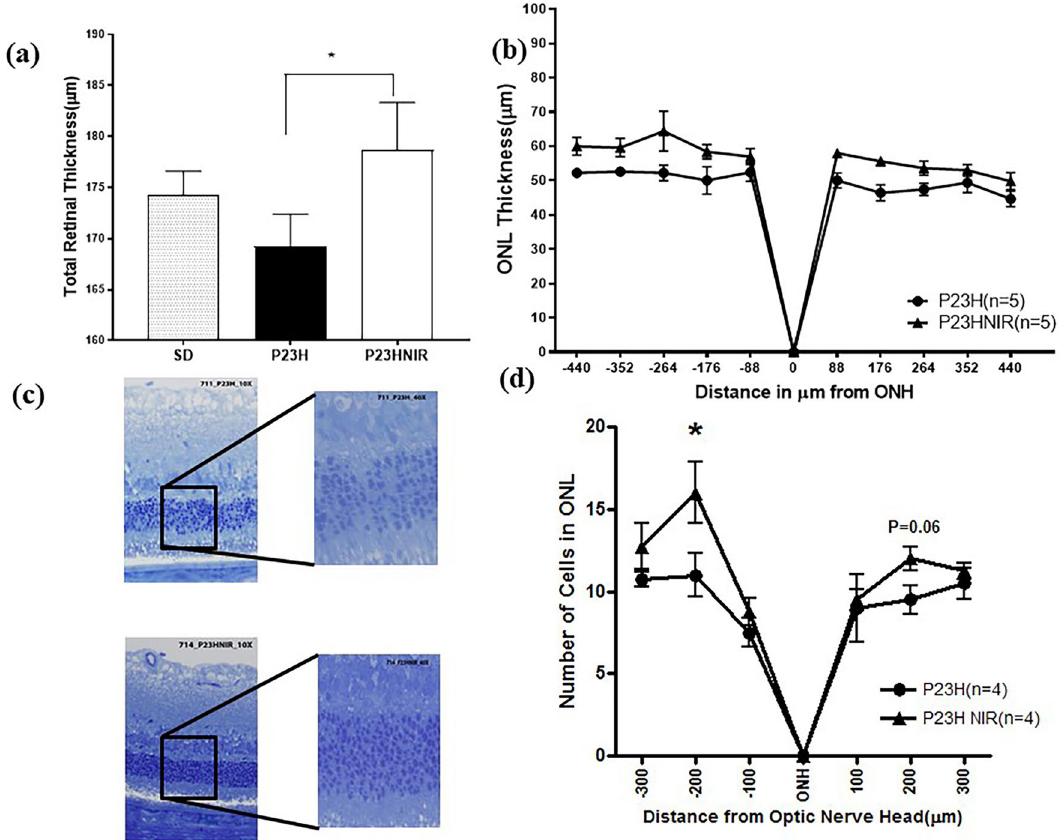
Figure 4. Photobiomodulation protects retinal structure and prevents photoreceptor cell loss. ( a ) compares the total retinal thickness in SD, P23H and 830 nm treated P23H rats. ( b ) compares ONL thickness from SD-OCT linear scans (1000 A-scans/B-scan, 80 B-scans) in sham and PBM-treated P23H rats. Total retinal thickness was significantly ( p < 0.05) greater in the 830 nm-PBM treated group compared to the sham-treated P23H group and SD control group. The ONL thickness of 830 nm PBM treated group (filled triangle) derived from Longitudinal Reflectivity Profile (LRP) was significantly greater (F (1,8) = 12.23, p < 0.01) compared to the sham-treated group (filled circle) across the entire scan. Error bars: SEM. ( c ) compares the representative images of retinal sections, stained with toluidine blue for the sham-treated group and the NIR-PBM-treated group. The photoreceptor nuclei (ONL) in the 830 nm PBM-treated group were more organized and symmetrically packed compared to the sham-treated photoreceptor nuclei, which were disrupted and disorganized. ( d ) shows the quantitative analyses of the ONL thickness sampled across the retina from the superior to the inferior edge (n = 4). ONL thickness in the 830 nm PBM-treated P23H group is significantly greater compared to the sham-treated P23H group. Error bars: